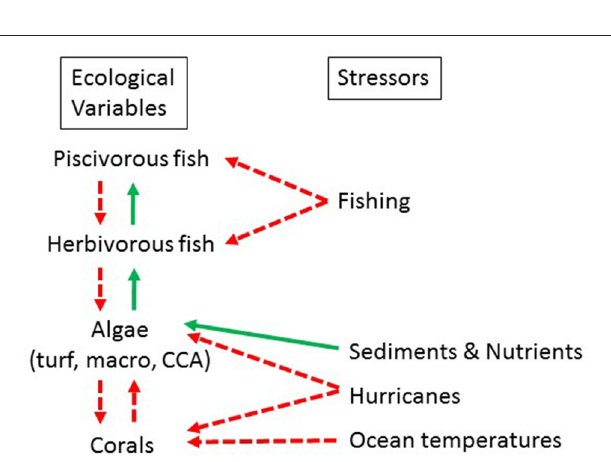
FIGURE 2 | Dynamic relationships between ecological variables and external stressors to the variables. A solid green arrow indicates a positive relationship and a dashed red arrow indicates a negative